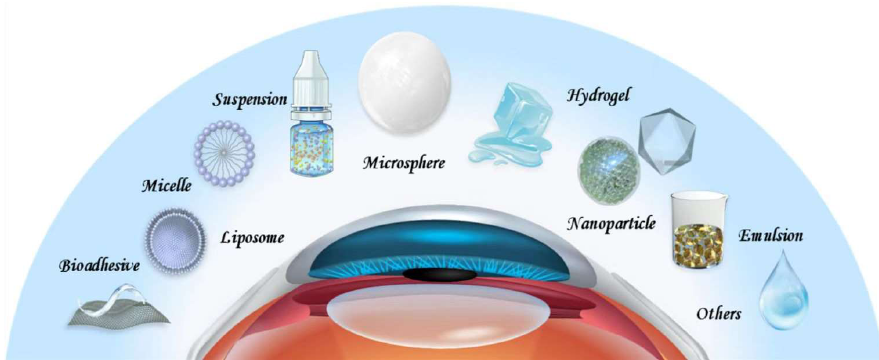
Figure 1. Drug delivery systems for DED. Table 1. Drug delivery systems for DED in the market or under clinical